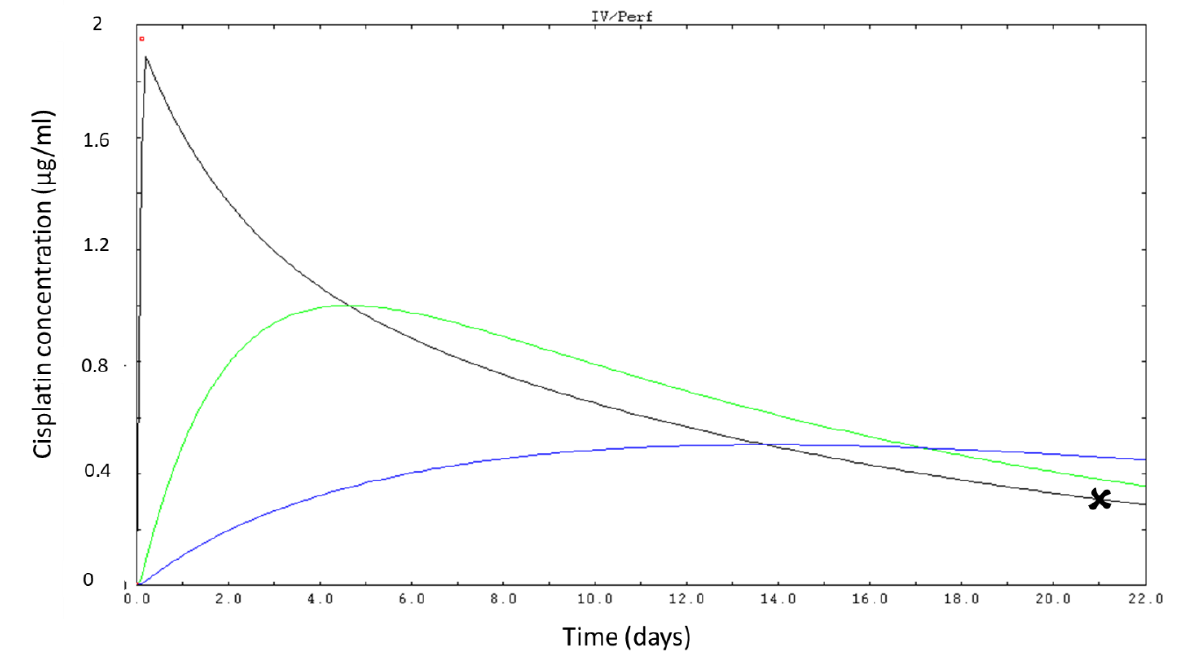
Figure 4. Simulation of plasma concentration of Cisplatin on D21 after Bayesian identification of cisplatin pharmacokinetic parameters in a representative patient. Red dot: measured concentration in plasma. Black line: first compartment, green line: second compartment, blue line: third compartment. Black cross: simulated plasma level on D21 (Kinetic Pro software caption).